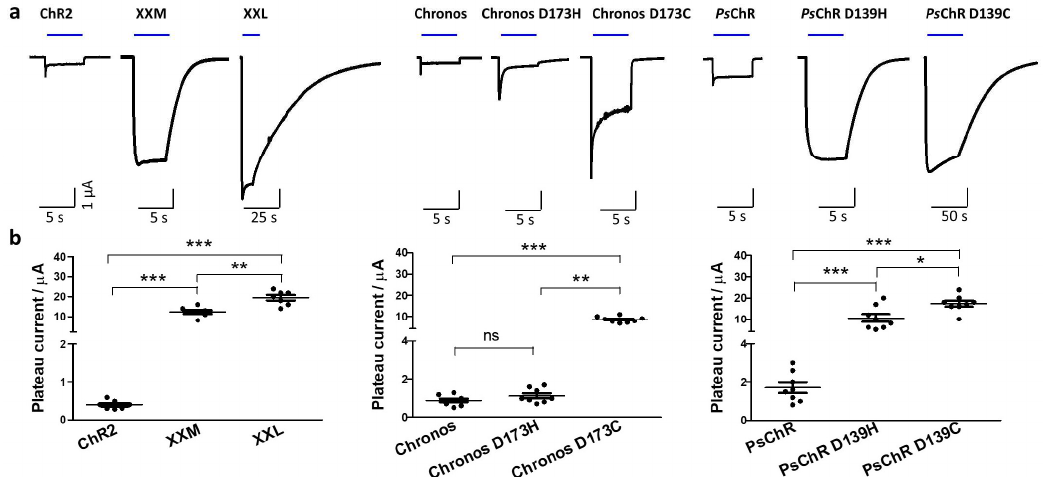
Figure 1. Comparison of ChR2, Ps ChR, and Chronos variants. ( a ) Representative photocurrent traces of ChR2, Ps ChR, Chronos, and their mutants. ( b ) Comparison of stationary photocurrents of above channelrhodopsin variants. All data points were plotted in the figure and mean ± standard error mean (SEM) (n = 7-8) was indicated. Table 1. Basic properties of ChR2, Ps ChR, and Chronos variants. 146 Expression* I s